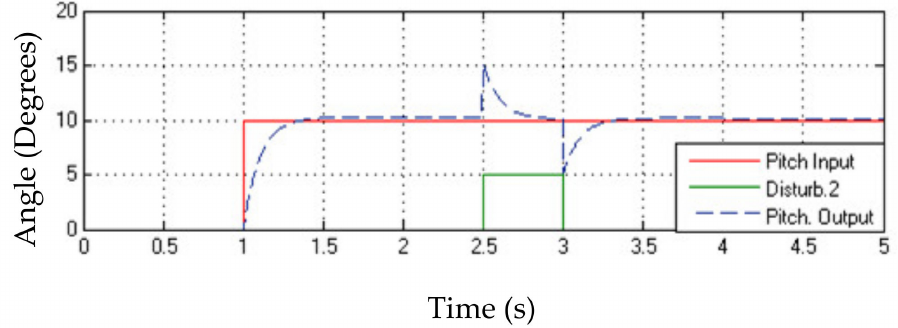
Figure 13. Fuzzy–PD response (the same for Mandami and Sugeno types) to a step of 10 ◦ with a disturbance of 5 ◦